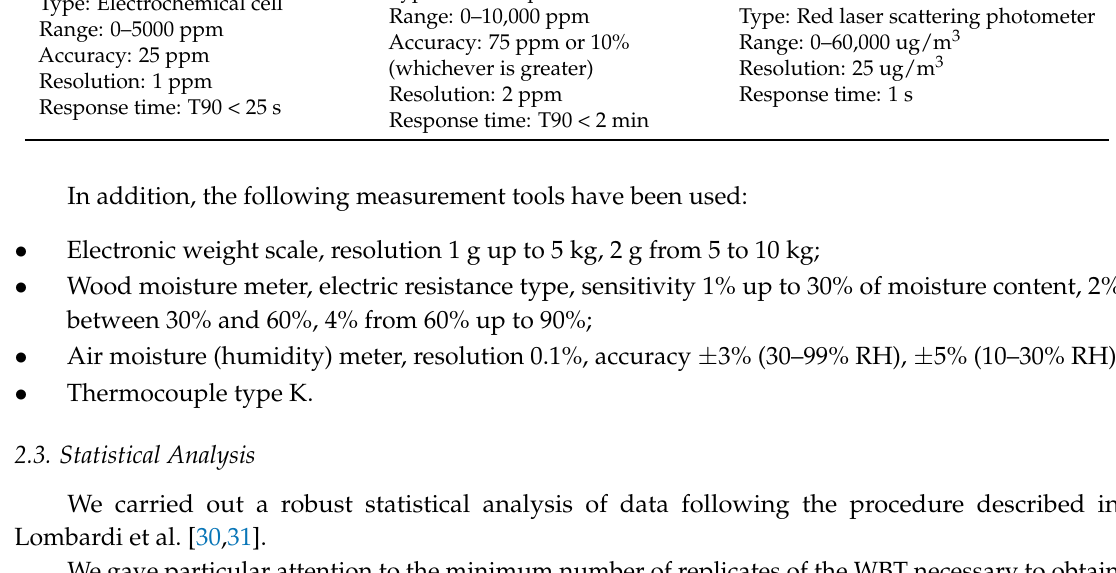
Table 1. Portable Emission Monitoring System (PEMS) sensors.